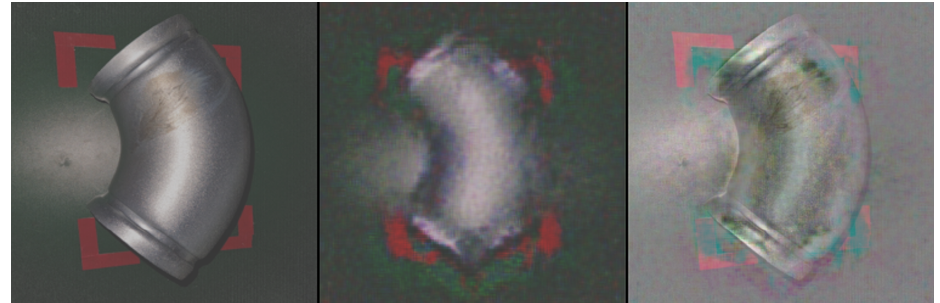
Figure 11. Top Crack Image Data Comparison.